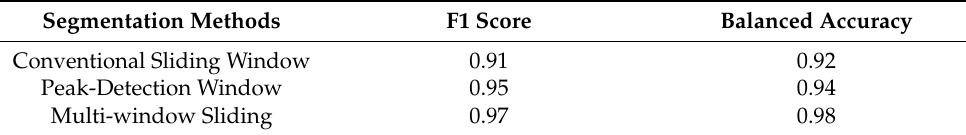
Table 1. Results for the different segmentation